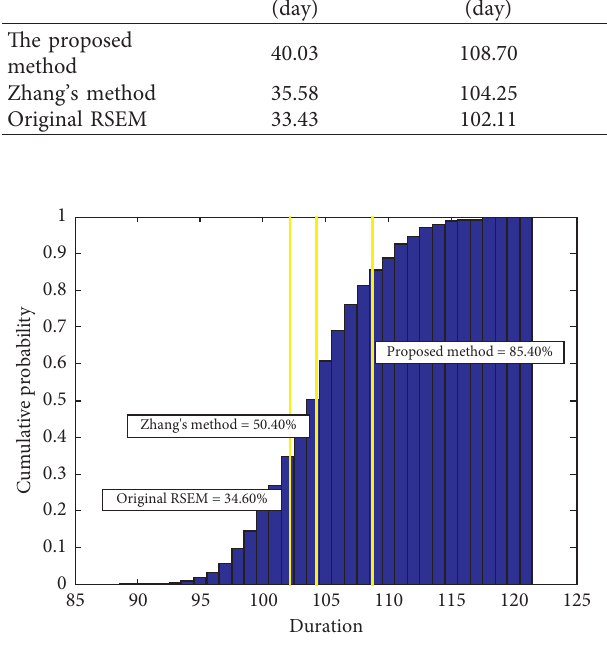
Figure 13: Comparison of on-time project completion probabil- ities between the proposed method, the original RSEM, and Zhang’s method-based